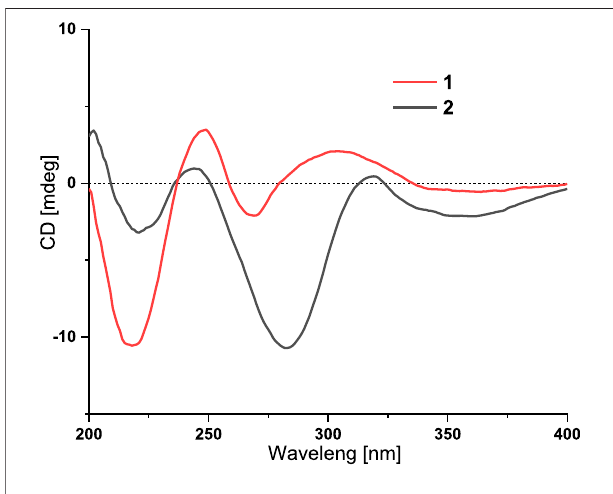
FIGURE 4 | The experimental ECD spectra of 1 and 2